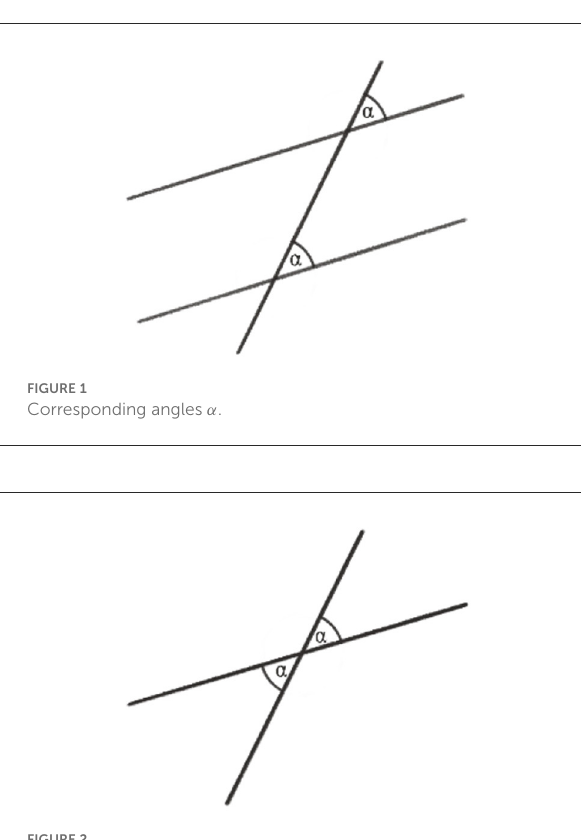
FIGURE2 Opposite angles α .